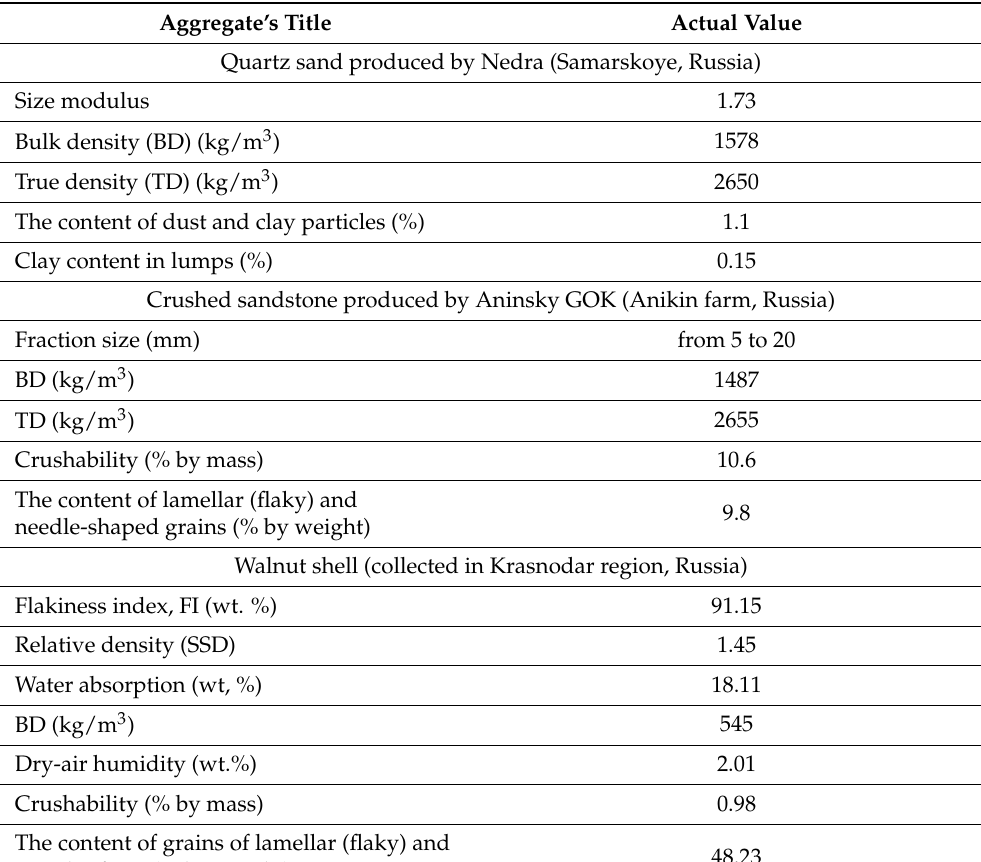
Table 2. Characteristics of